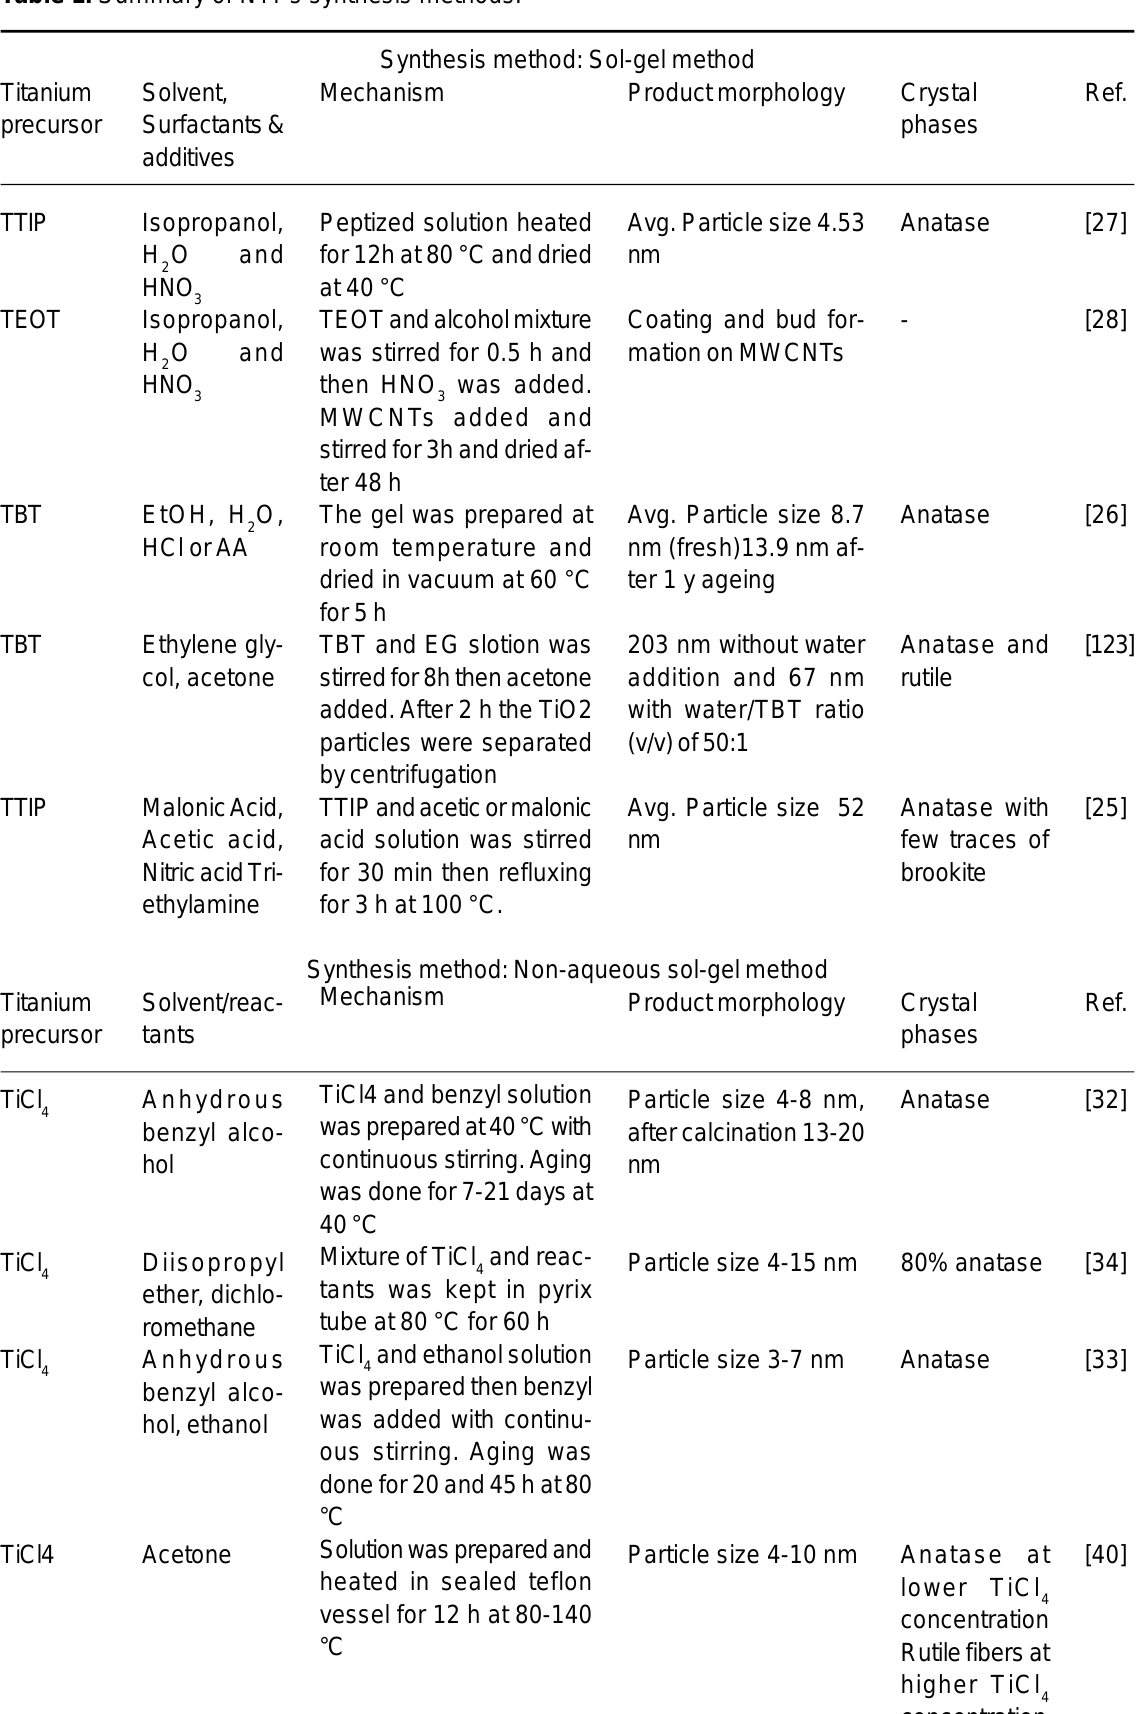
Table 1. Summary of NTPs synthesis methods. Synthesis method: Sol-gel